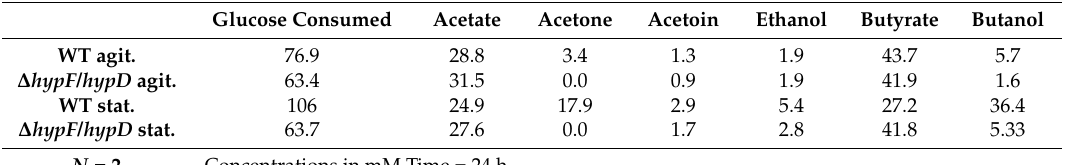
Table 1. Metabolic output of wild type (WT) and mutant strains in static planktonic (stat.) and agitated (agit.) cultures grown on CGM containing 5.0% glucose in anaerobic bioreactors. Glucose Consumed Acetate Acetone Acetoin Ethanol Butyrate Butanol WT agit.